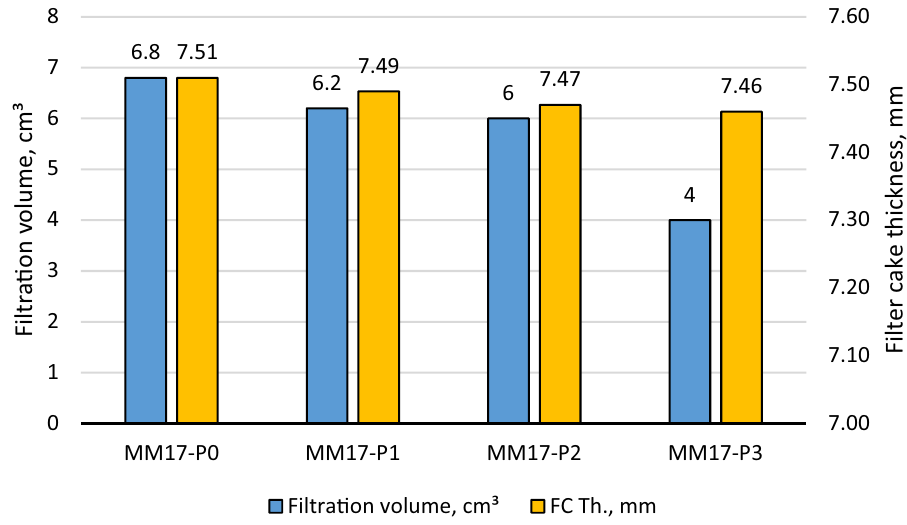
Figure 5. Filter cake thickness and filtration volume as function of perlite for mud density equal to 17.2 ppg.